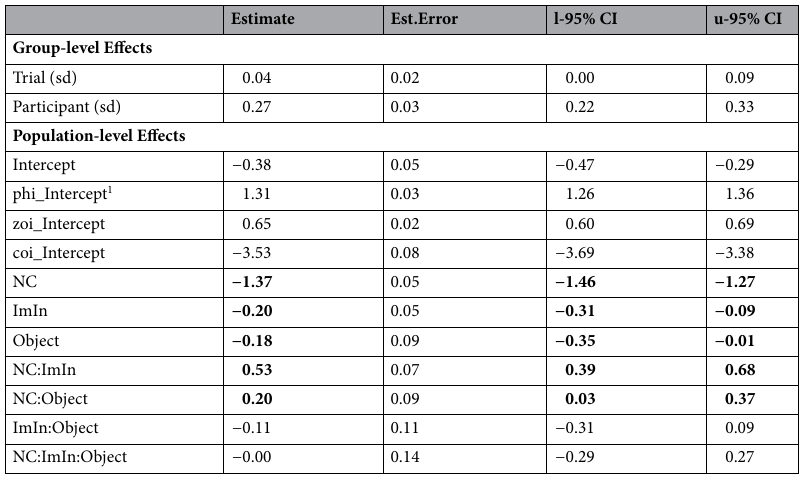
Table 2. Logit transformed regression coefficients (posterior mean, standard error, 95% credible intervals) of the continuous fixation proportion as a function of area of interest, task and object imagery scores. Phi_ Intercept = beta precision (dispersion) parameter ( 1 log transformed). Zoi_Intercept = zero–one inflation. Coi_ Intercept = conditional one inflation. NC = non-corresponding AOI. ImIn = image inspection. Object = object imagery scores. Estimates with credible intervals not including zero are indicated in bold.